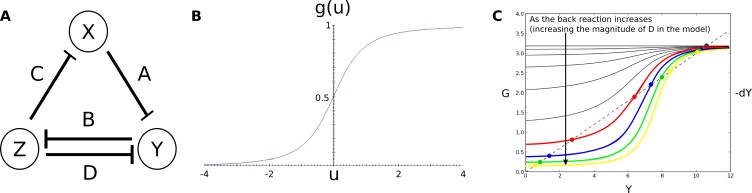
Connectionist AC/DC circuit.(A) Regulatory structure and parameters of the simulated AD/DC circuit. Nodes represent genes and their transcription-factor products. T-bars represent repressive regulatory interactions. All genes are constitutively activated. (B) Sigmoidal regulation-expression function used for the simulations (Equation 31). (C) The number of steady states in the connectionist AD/DC circuit, can be one (black curves), or three (coloured curves) depending on the strength of the back reaction.